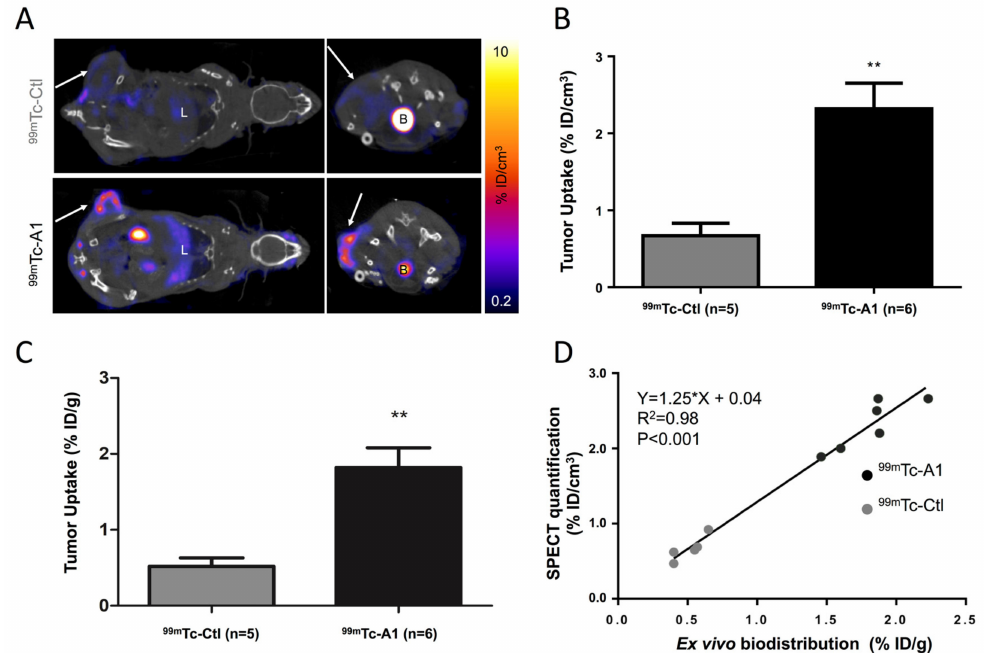
Figure 3. 99m Tc-A1 binds to AsPC-1 tumor in vivo. ( A ) Representative coronal and transversal views of fused SPECT-CT images of AsPC-1 tumor-bearing mice one hour after IV injection of 99m Tc-Ctl (n = 5) or 99m Tc-A1 (n = 6). B: bladder and L: liver. Tumor is indicated by the white arrow. ( B ) In